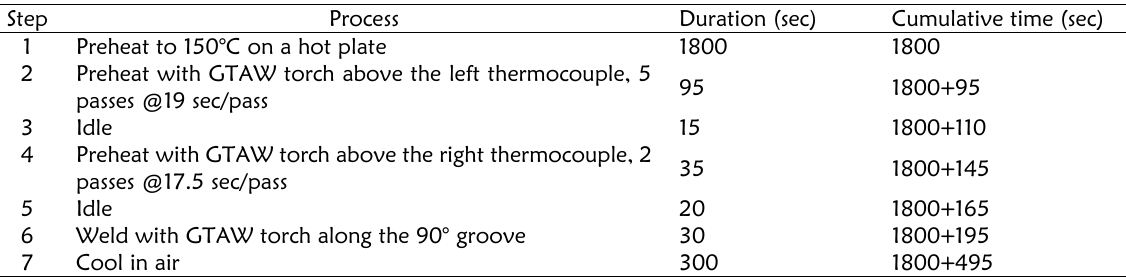
Table 3: Preheating and welding